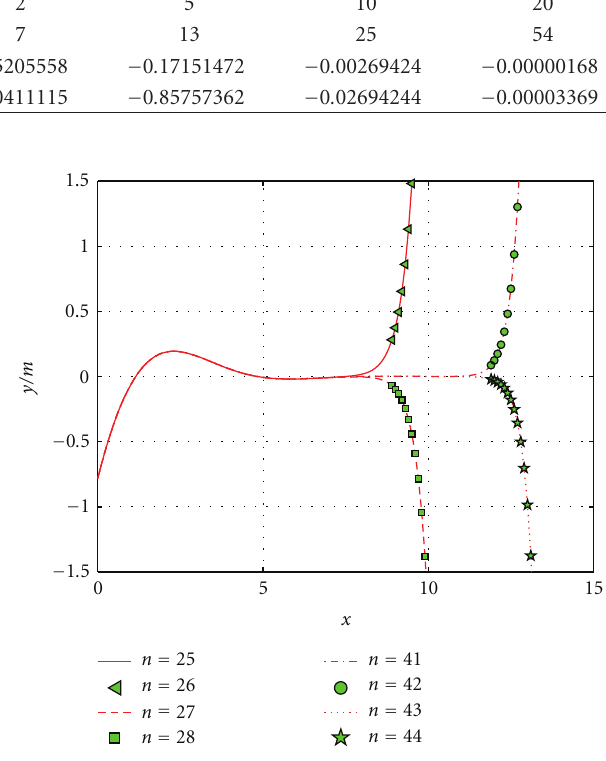
Figure 3: Normalized profile shape due to volume di ff